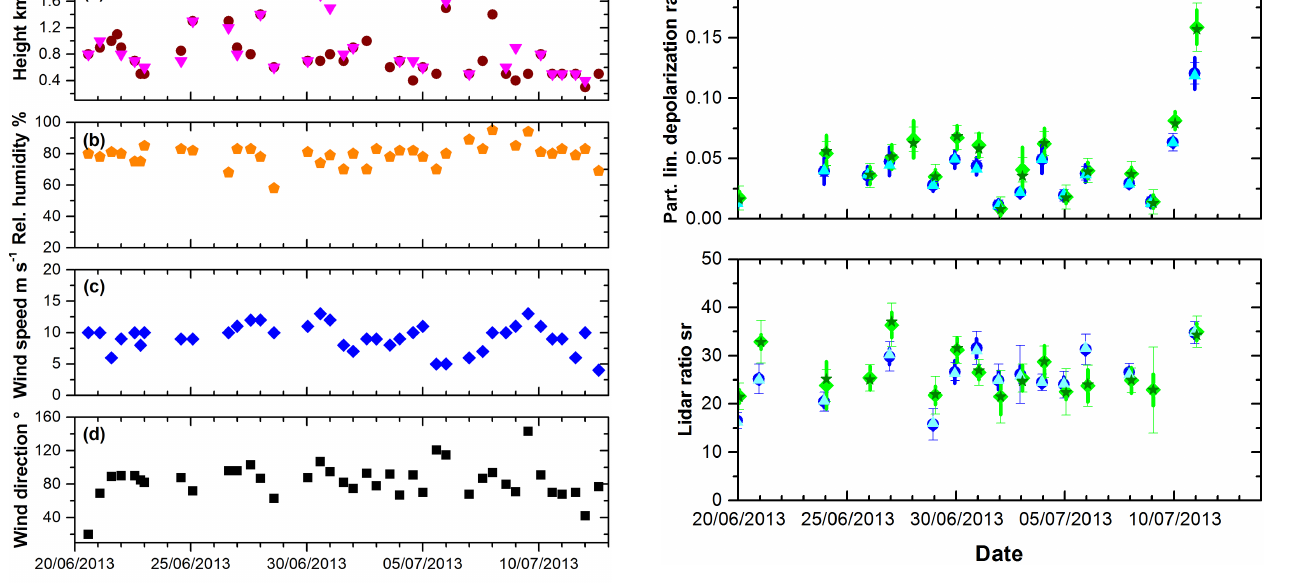
Figure 4. Mean values, median, standard deviation of the mean and mean systematic error of the particle linear depolarization ra- tio (upper panel) and the lidar ratio (lower panel) at 355 and 532nm measured with POLIS within the convective marine boundary layer. Blue dots and green diamonds show the mean values at 355 and 532nm, light blue triangles and dark green stars show the median values at 355 and 532nm, thick lines show the standard deviation of the mean, and the thin error bars denote the mean systematic